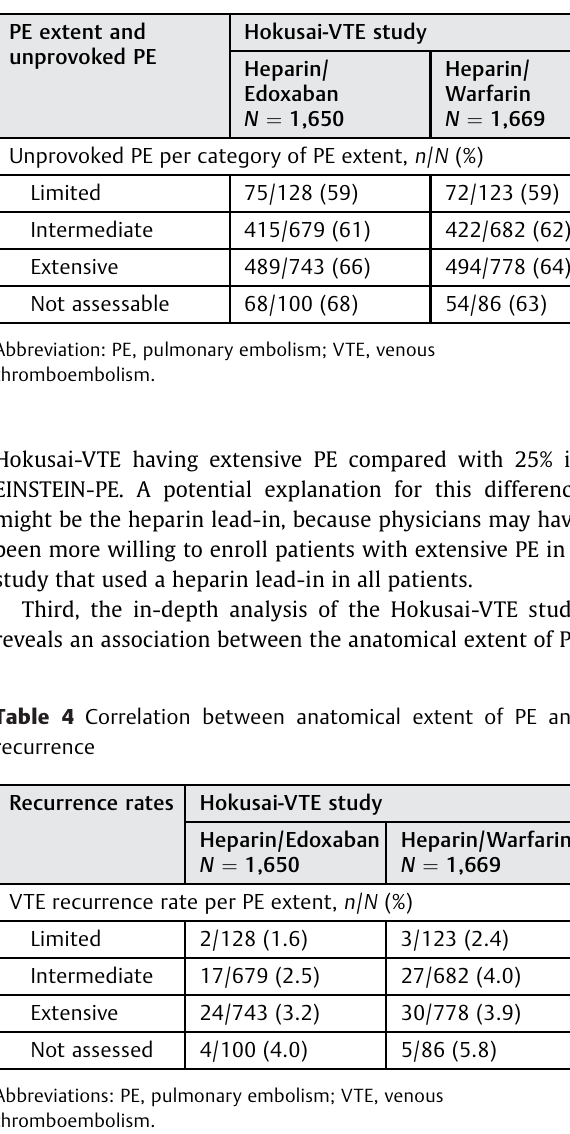
Table 3 Anatomical extent of PE and the proportion of patients with unprovoked PE